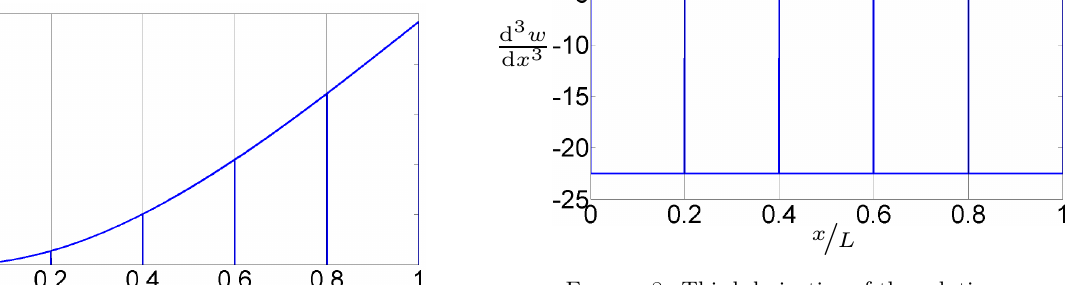
9/10 Figure 8. Third derivative of the solution